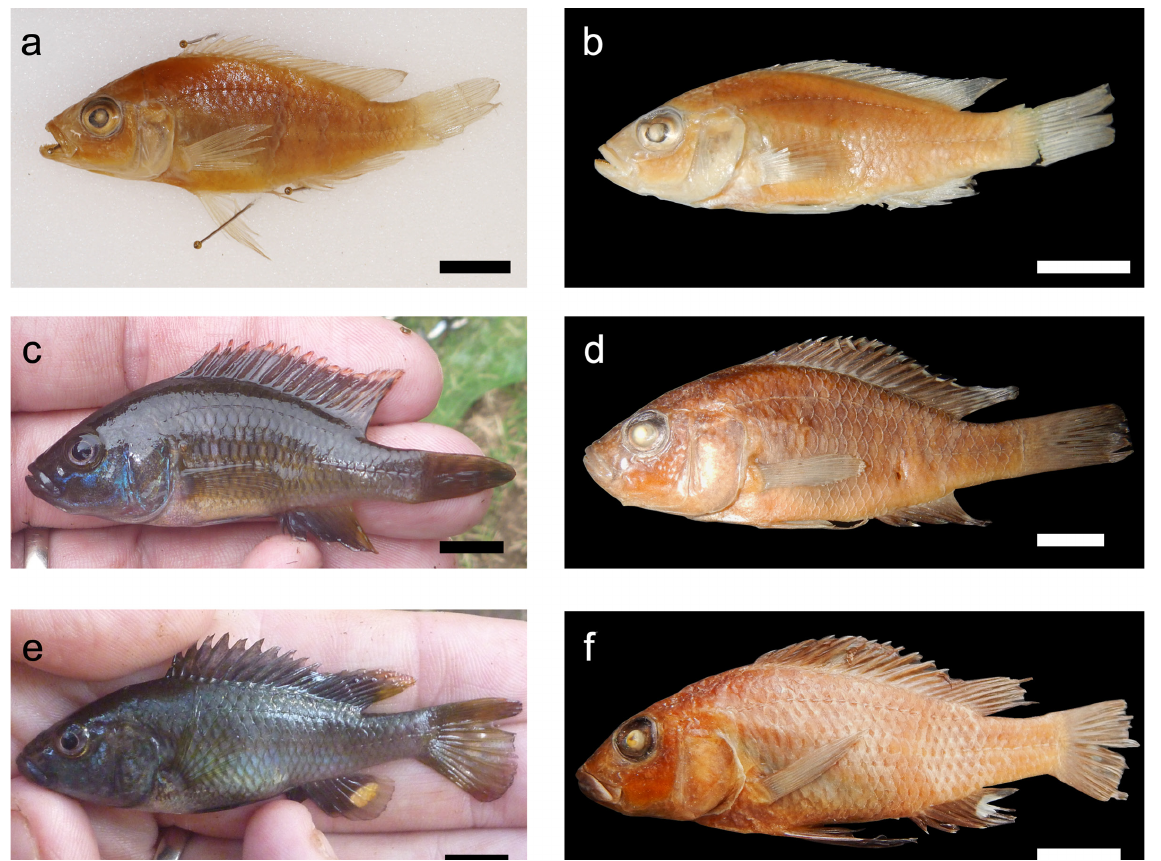
Fig. 6. a . Ctenochomis pectoralis Pfeffer, 1893, lectotype ZMH402 from Korogwe (imaged by Thilo Weddehage). b . C. pectoralis , paralectotype BMNH 1899.2.27.1 from Korogwe. c . C. pectoralis , ♂ from Ruvu River shortly after capture (part of BMNH 2021.7.15.1-3). d . C. pectoralis , ♂ from Ruvu River preserved state (part of BMNH 2021.7.15.1-3). e . C. scatebra Genner, Ngatunga & Turner sp. nov., ♂ from Chemka Springs shortly after capture (part of BMNH 2021.7.15.1-3). f . C. scatebra sp. nov. holotype BMNH 2021.7.15.4. Scale bars: 10